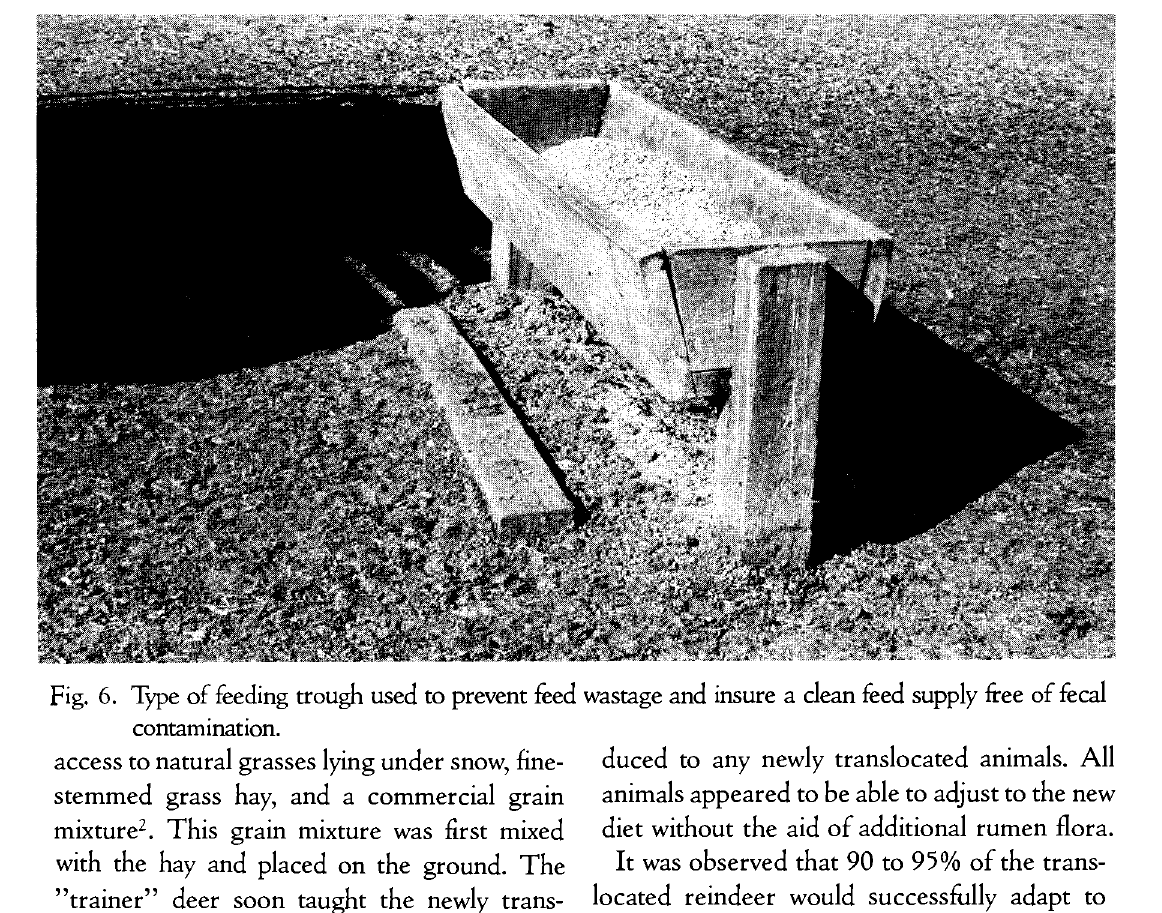
Fig. 6. Type of feeding trough used to prevent feed